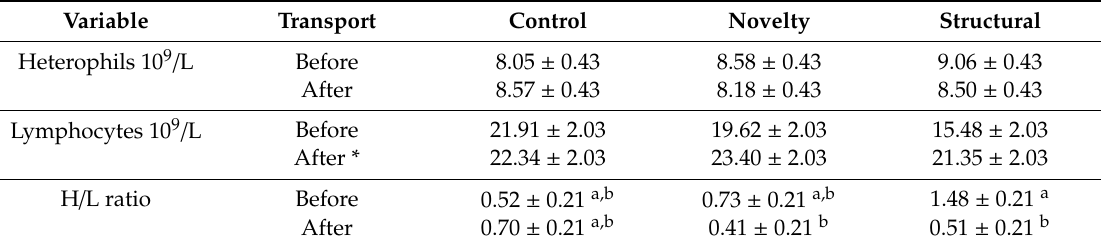
Table 4. The least squares means ± SEM concentrations of heterophils and lymphocytes and the heterophil / lymphocyte ratio for pullets from three rearing enrichment treatments (control: n = 30, novelty: n = 30, structural: n = 30) sampled before and after transport to the layer facility.